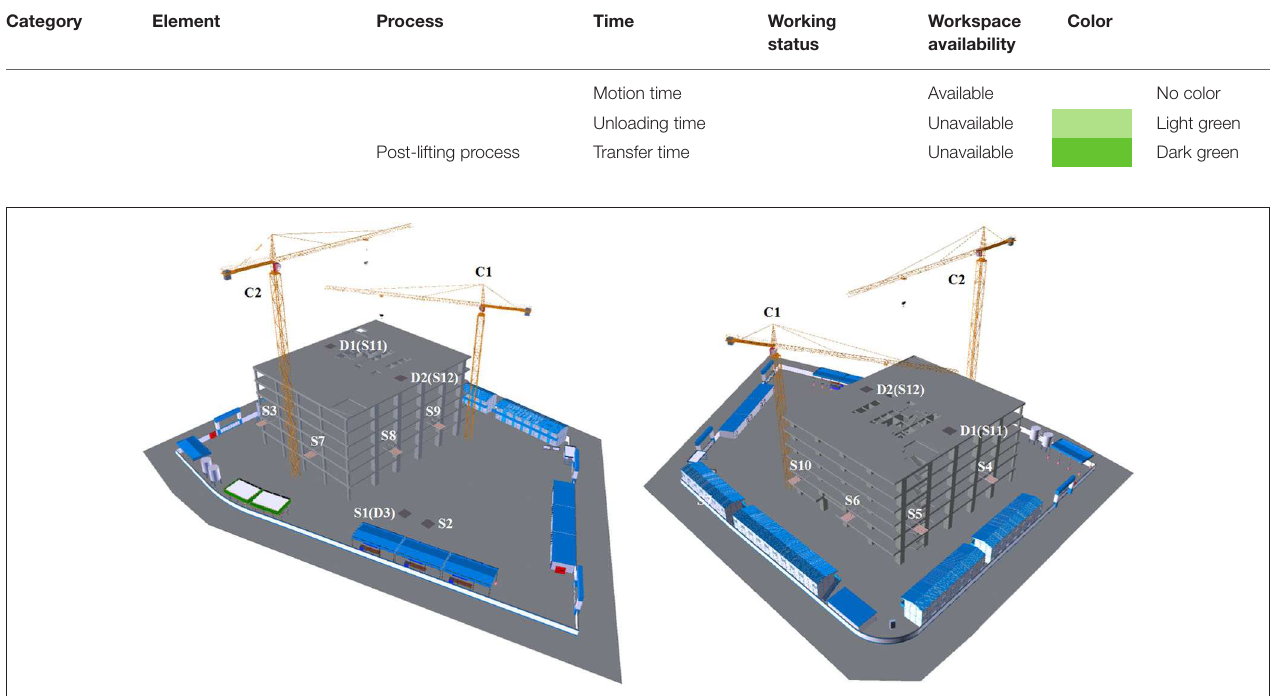
FIGURE 3 | 3-D model for the